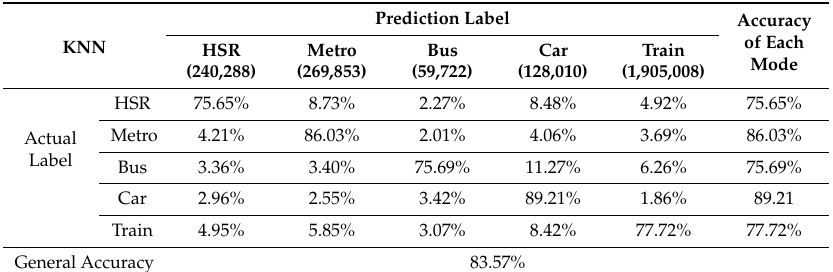
Table 10. Confusion matrix for K-nearest neighbor with the proposed features.